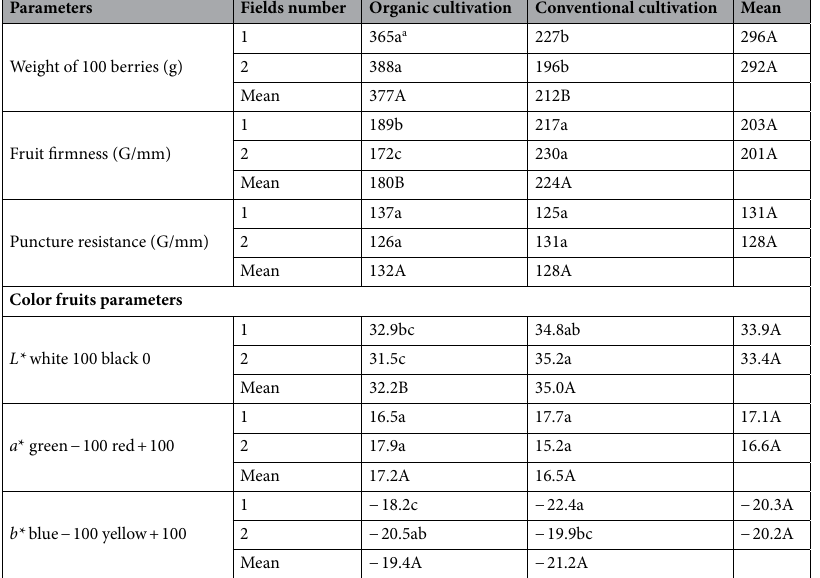
Table 3. Quality and colour of fresh blueberry fruit, depending on the cultivation method. a Mean values denoted by the same letter do not differ statistically significantly at 0.05 according to t-Tukey test; lower-case letters indicate interaction and capital letters the main factors.